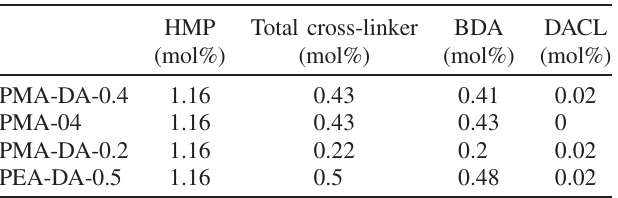
TABLE III. Parameters used for the estimation of areal chain density. Values of C ∞ and ρ are from Ref.